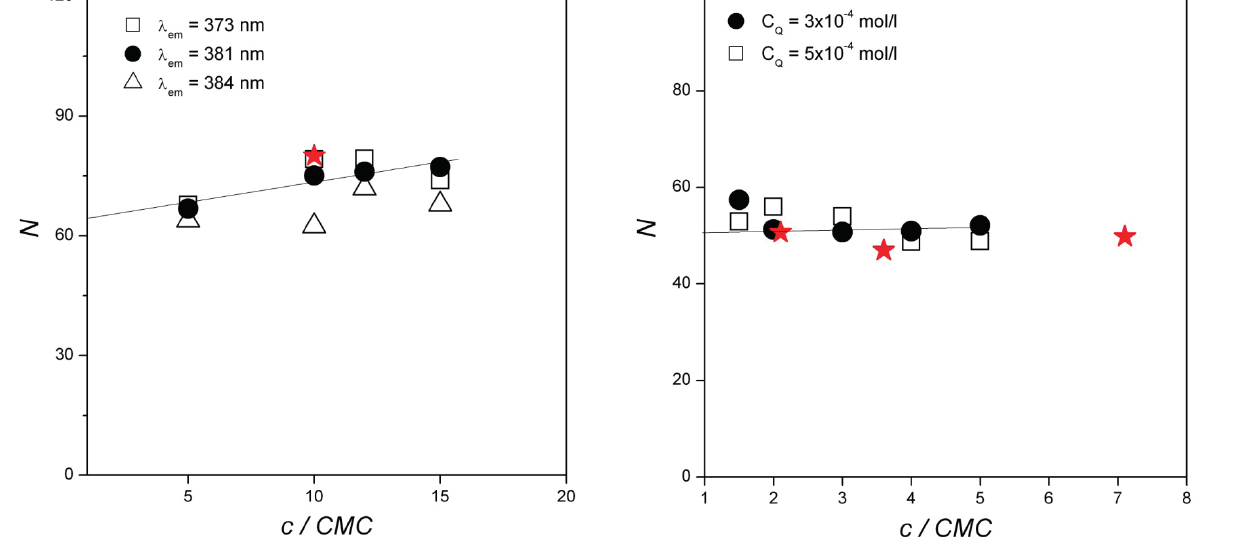
Figure 3: DTAB concentration dependence of aggregation number N for two quencher concentrations c . The published aggregation Q number values taken from [13,39-41] are denoted by star